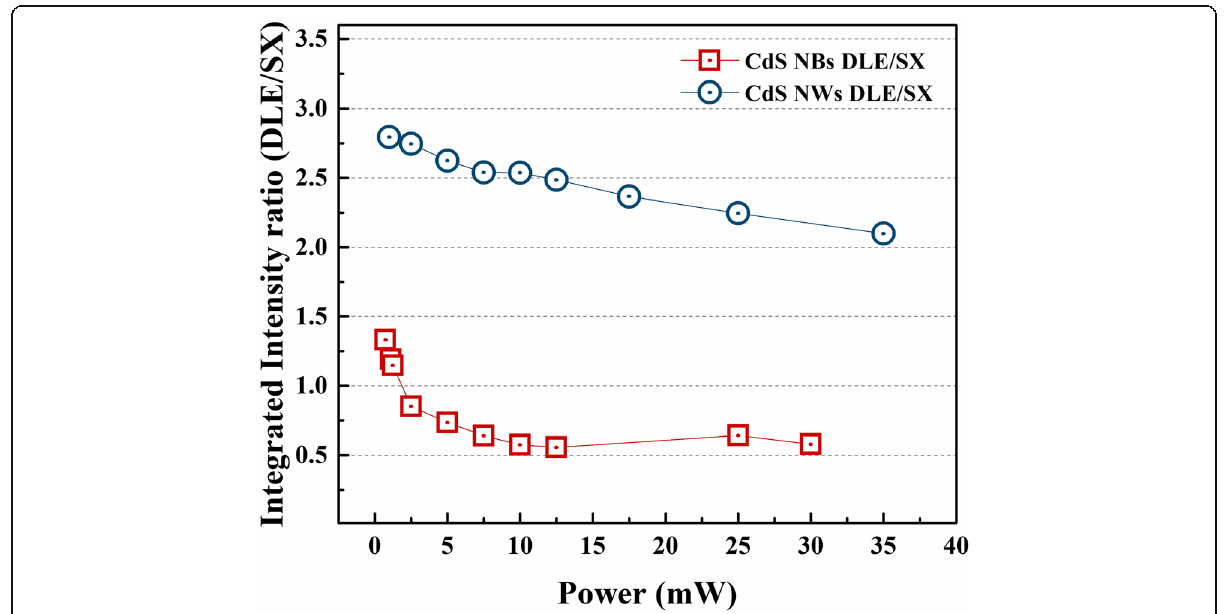
Fig. 4. Integrated PL intensity ratio of DLE emission and SX emission in CdS NBs and NWs samples at room